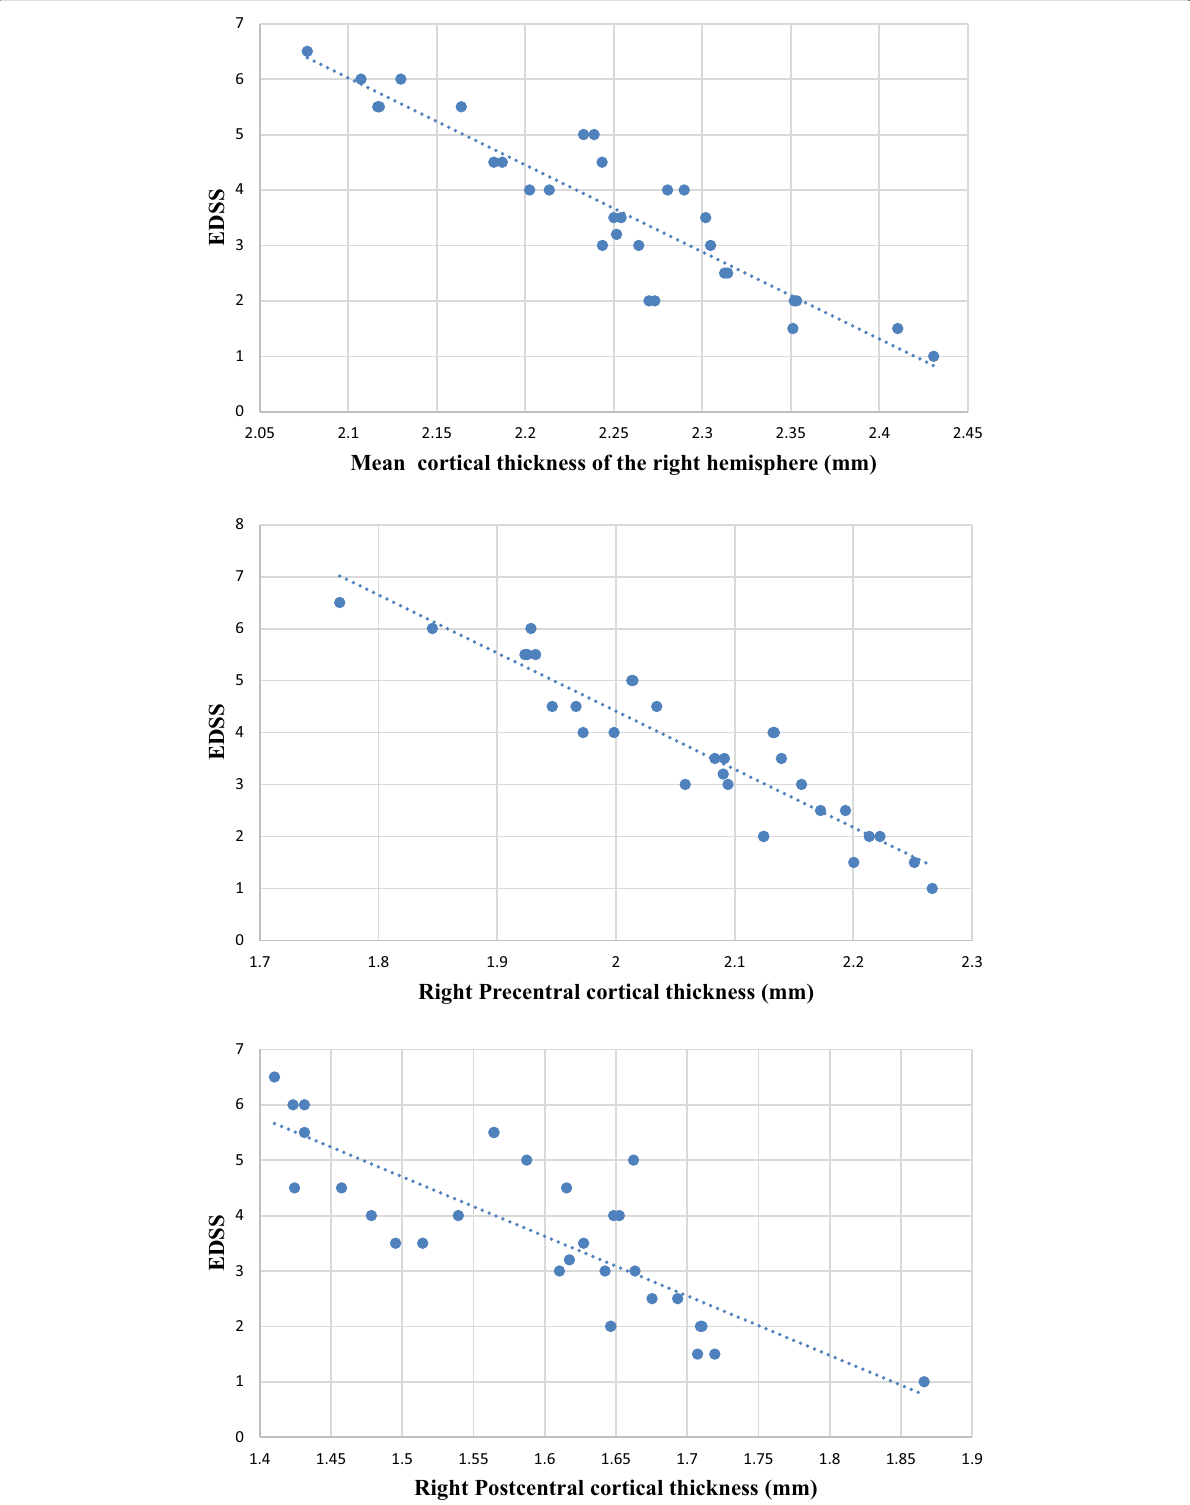
Fig. 6 Correlation between the mean cortical thickness of the right hemisphere, the right precentral, postcentral, paracentral, posterior cingulate cortical thickness and EDSS